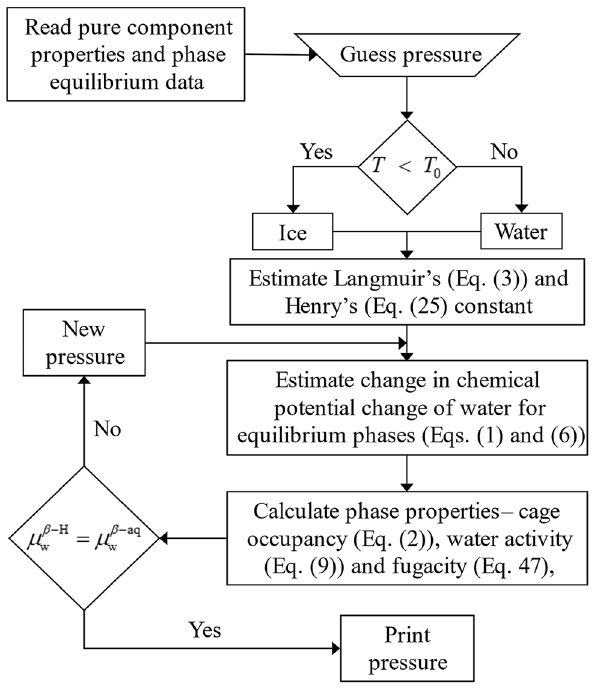
Figure 1. Computational algorithm to search hydrate equilibrium